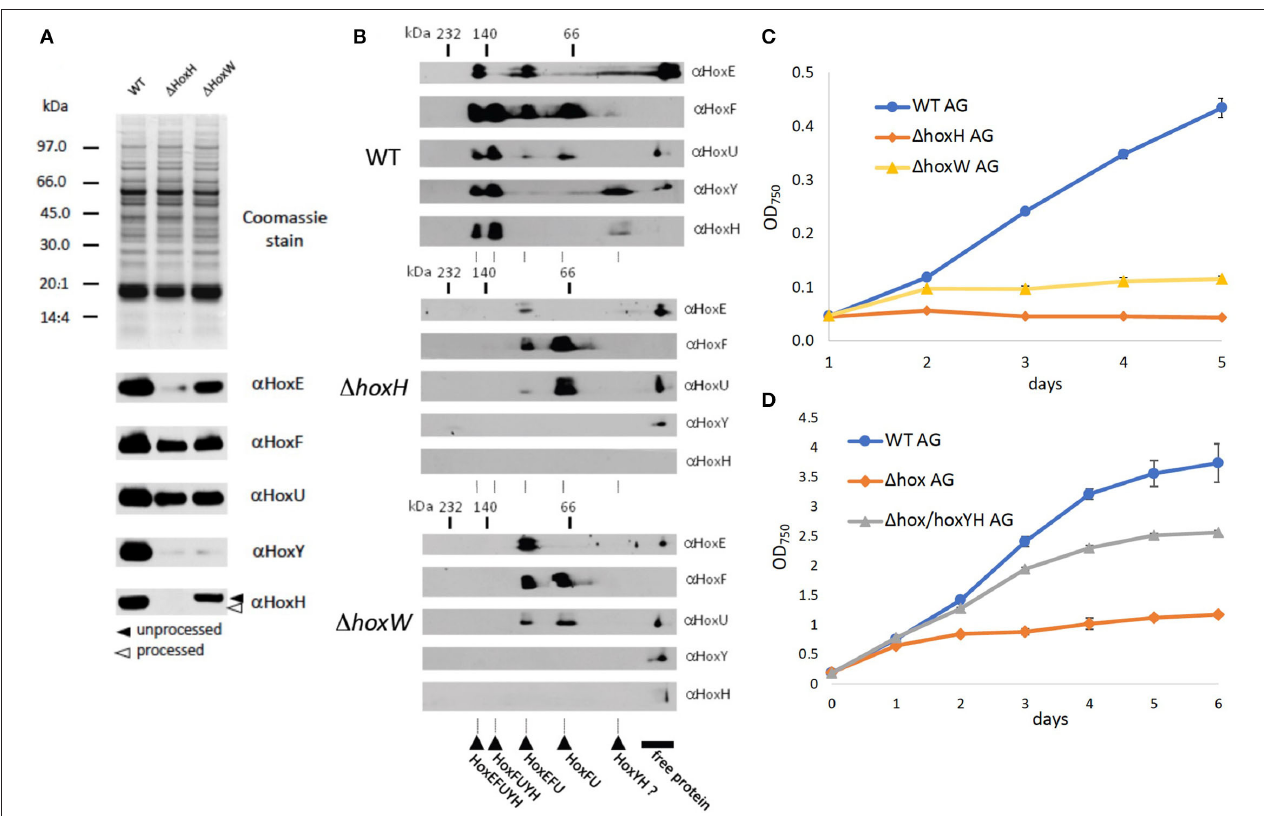
FIGURE 4 | Significance of the diaphorase and the hydrogenase on arginine and glucose. (A) SDS page and immunoblots of WT, 1 hoxH, and 1 hoxW with antibodies against all hox subunits (B) 2D Blue Native PAGE of WT, 1 hoxH, and 1 hoxW with antibodies against all hox subunits. The second dimension allows to check for the assembly of complexes. (C) Growth of WT, 1 hoxH, and 1 hoxW on arginine and glucose. (D) Complementation of 1 hox with hoxYH ( 1 hox /hoxYH). Growth of WT, 1 hox/hoxYH, and 1 hox on arginine and